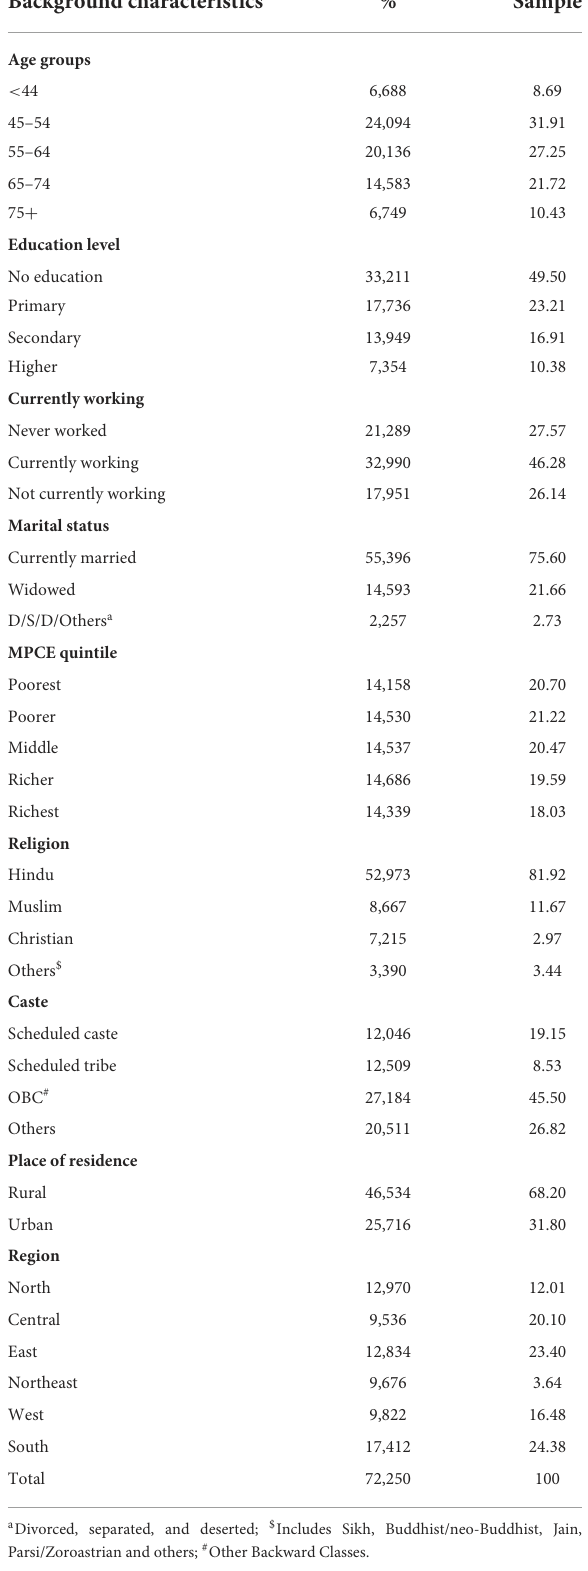
TABLE 1 Socio-demographic and economic profile of adults in India,